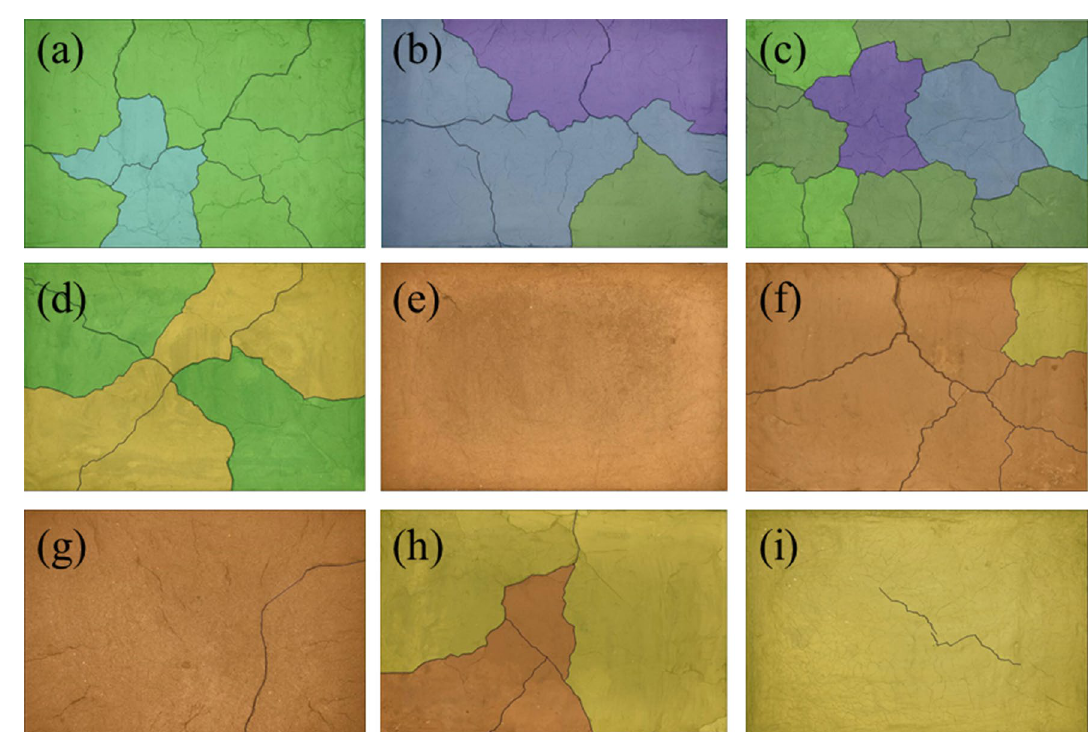
Figure 11. Nominal surface strength results of freeze–thaw orthogonal test. ( a ) A 1 B 1 D 1 , ( b ) A 1 B 2 D 2 , ( c ) A 1 B 3 D 3 , ( d ) A